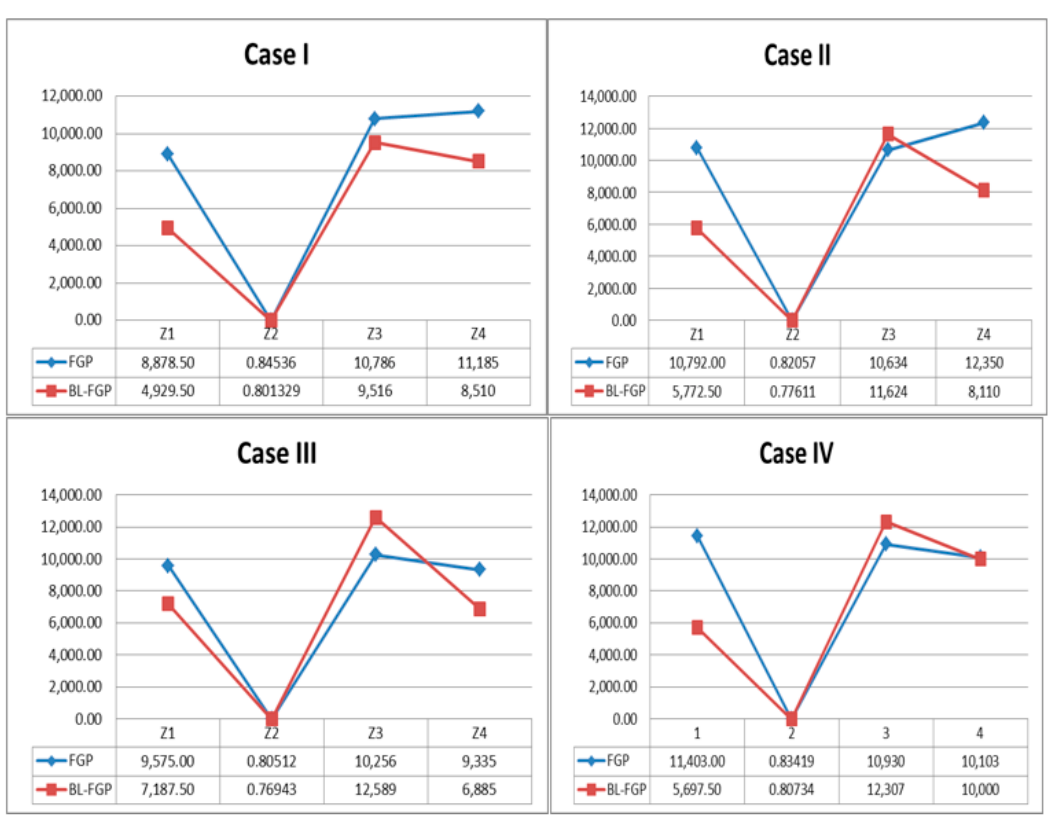
Figure 1. Compromise solution of different cases.